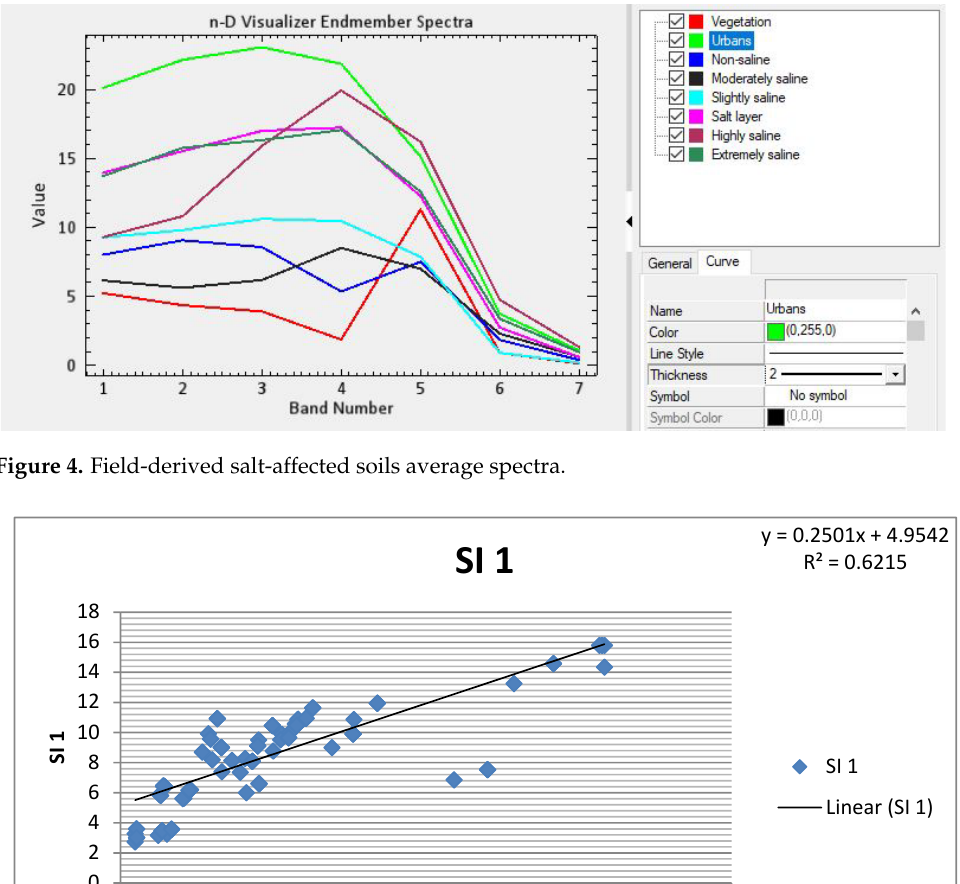
Figure 4. Field-derived salt-affected soils average spectra.